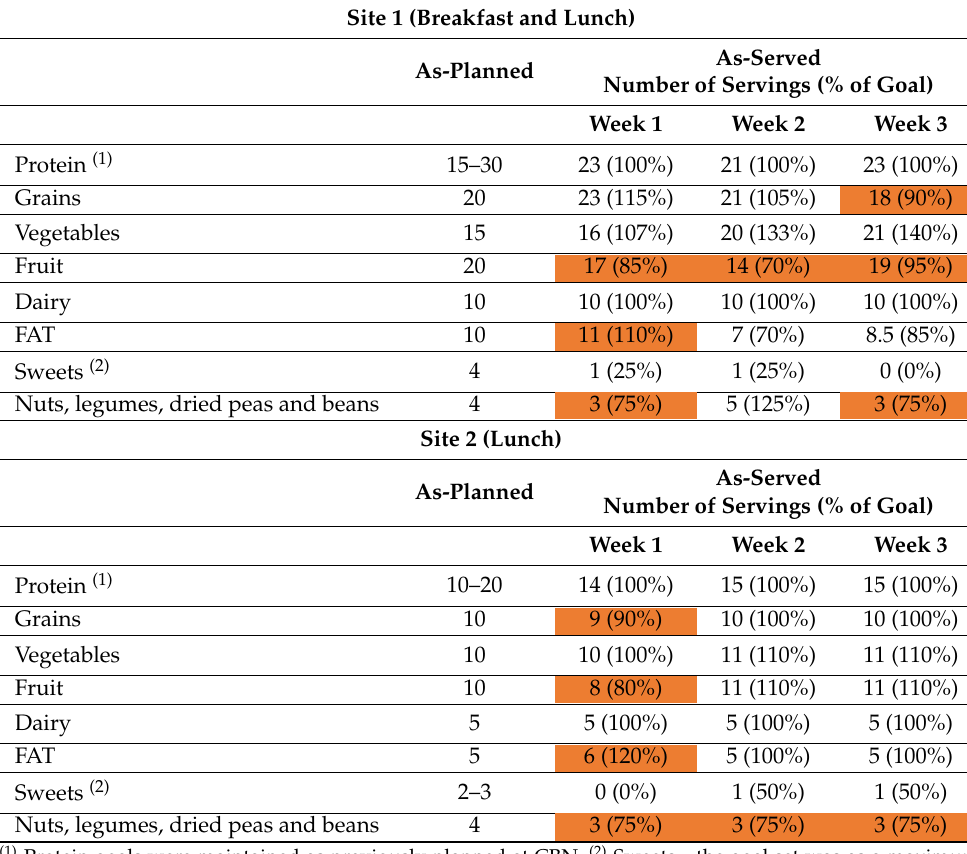
Table 3. Concordance of DASH congregate meals as-planned and as-served (3)